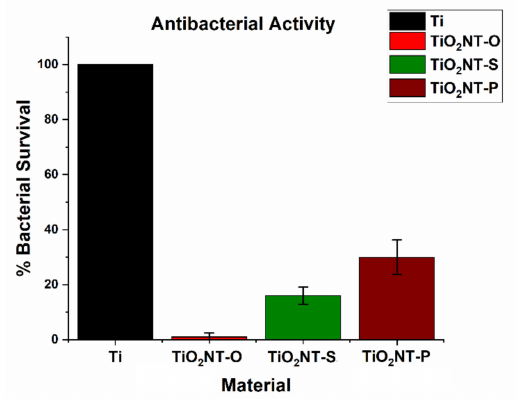
Figure 12. Effect of morphology on E. coli inactivation